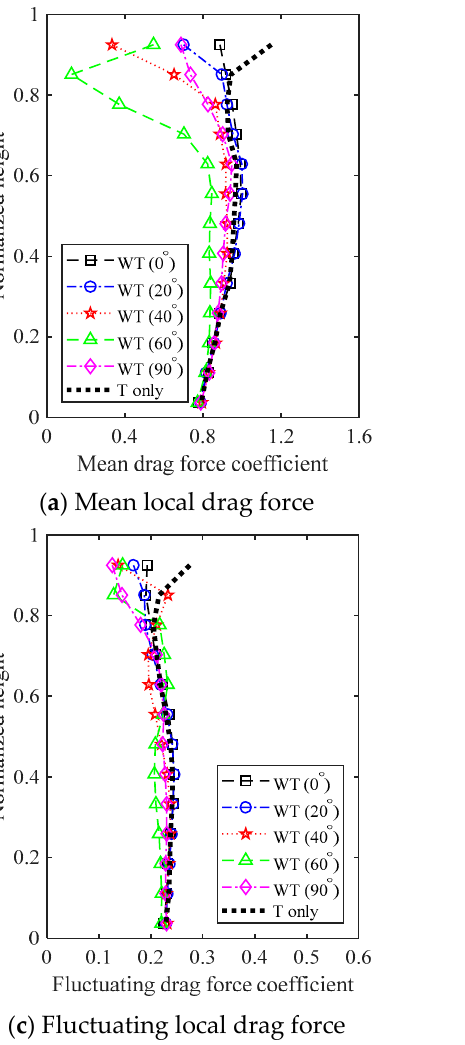
Figure 11. Variation of local force coefficients of tetradecagonal wind turbine at θ pit = 90° and θ azi = 90°.